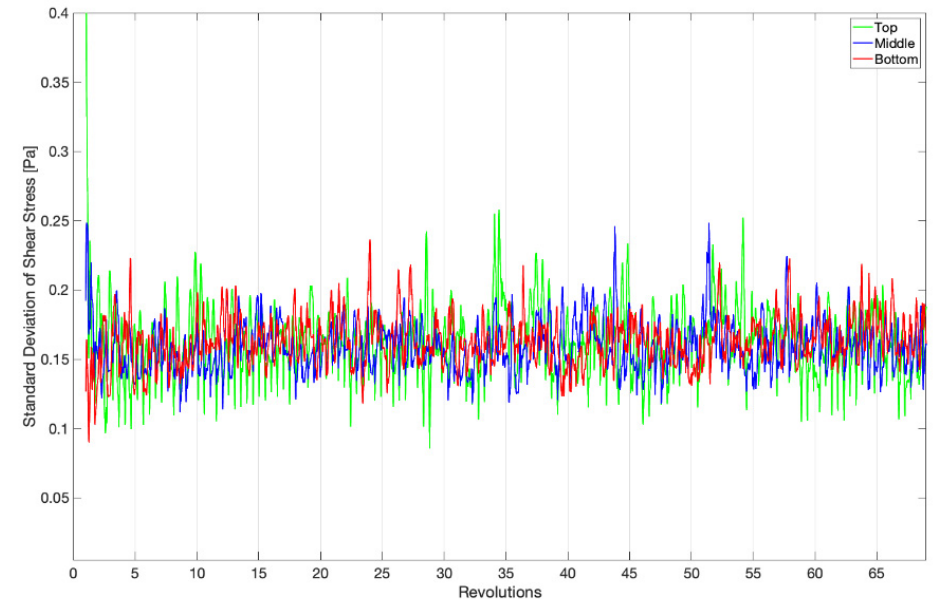
Figure 4. Averages of the instantaneous standard deviations of the total shear stress on each coupon surface for the top, middle, and bottom rows of coupons.